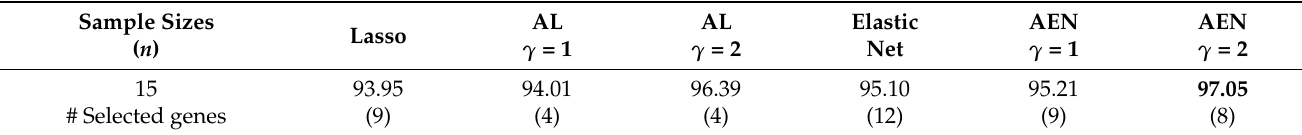
Table 6. The average percentage of accuracy and the average number of selected genes of lasso, adaptive lasso (AL), elastic net, and adaptive elastic net (AEN) under 20 leukemia genes .